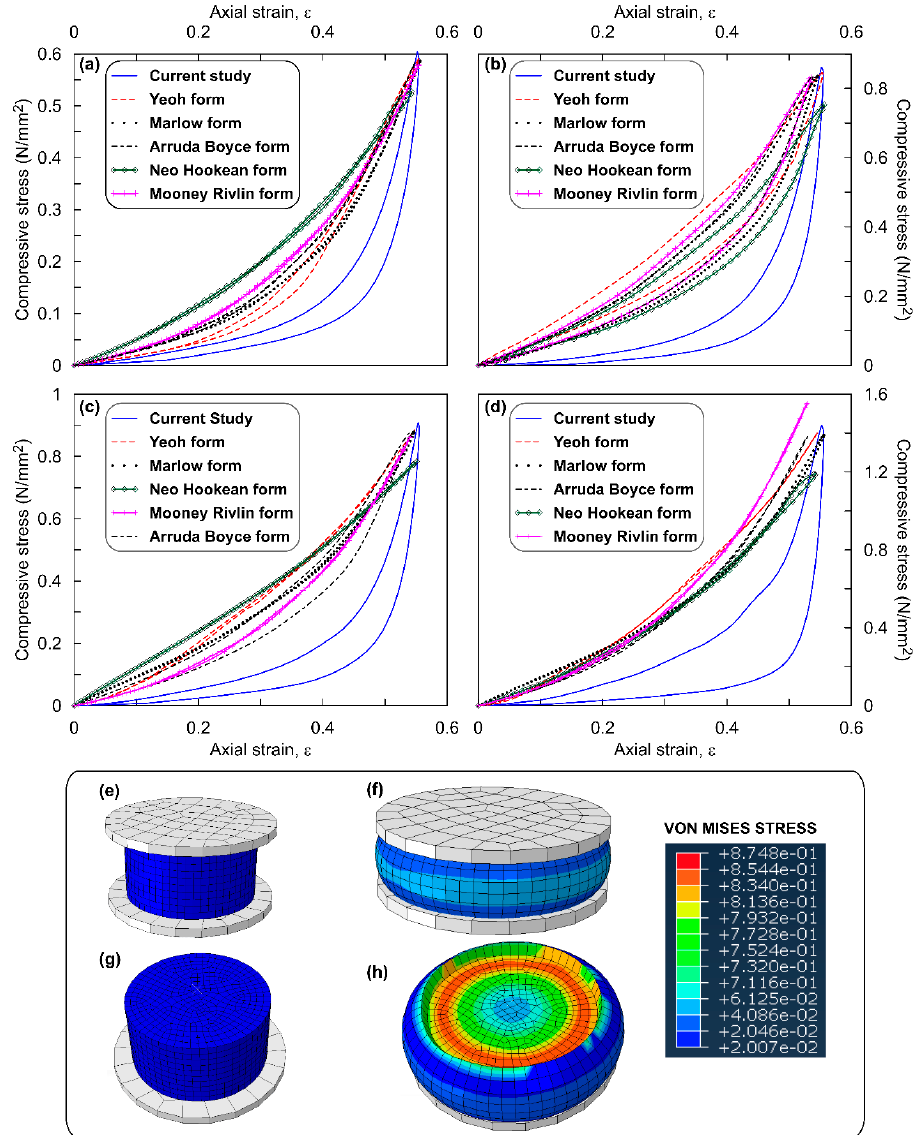
Figure 3. Stress–strain response of circular ROPS composites: ( a ) 0% OPS; ( b ) 5% OPS; ( c ) 10% OPS; ( d ) 20% OPS content; ( e ) undeformed ROPS model; ( f ) deformed ROPS model; ( g ) top-view of undeformed model at ε ≈ 50%; ( h ) top-view of deformed model with stress contours at ε ≈ 50%.